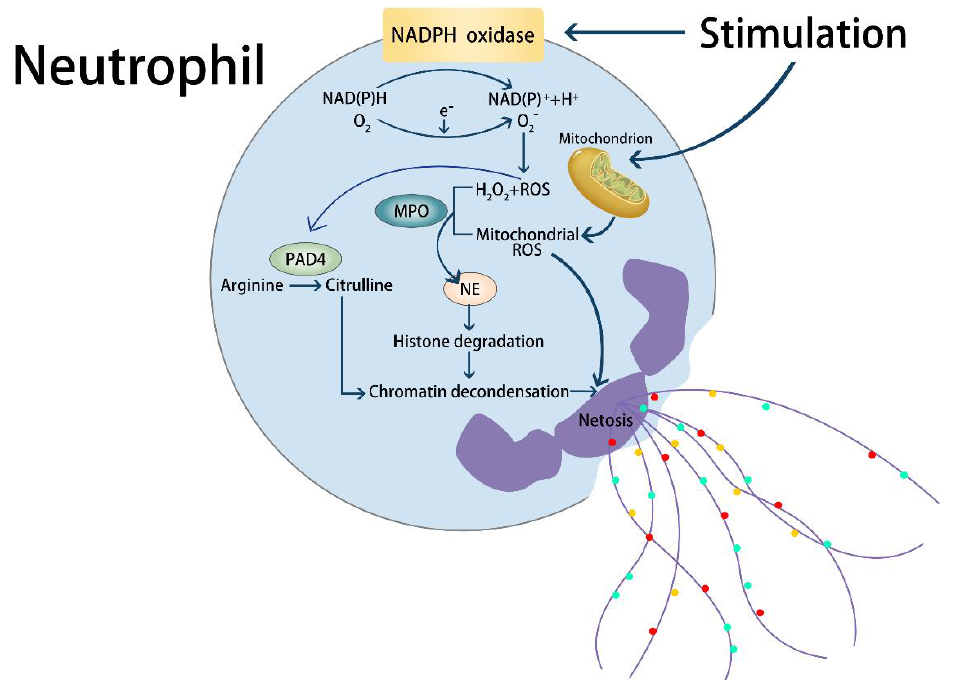
Figure 1. The biomolecular mechanism of NETosis. Extracellular stimulation activates corresponding on-membrane receptors, thereby releasing NETs through different intracellular pathways. During NETosis, the activated neutrophils secrete reactive oxygen species (ROS) via nicotinamide adenine dinucleotide phosphate (NADPH) or mitochondria, which then activates myeloperoxidase (MPO), further facilitating the release of neutrophil elastase (NE) from cytoplasmic particles and the translocation into the nucleus. Nucleic NE degrades histones and disrupts the assembly of chromatin in the nucleus, resulting in chromatin. At the same time, peptidyl arginine deiminase 4 (PAD4), locates the downstream of ROS, catalyzes the deamination and citrullination of histone arginine residues and then promotes chromatin decondensation, which is the crucial point within NETosis.